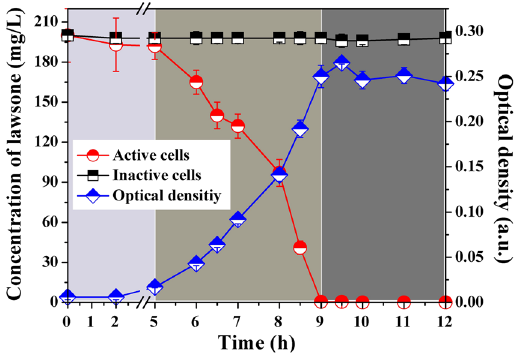
Figure 3. Degradation of lawsone in liquid MSM with the inoculation of active and inactive strain LH-3 and the corresponding growth profile (OD 600 ) of active cells. The initial concentration of lawsone was 200 mg L − 1 and the inoculated amount of LH-3 was 1%, the inactive cells indicated the autoclave-killed cells, the growth curve was divided into three parts as filled with different colors, error bars represented the standard error of three